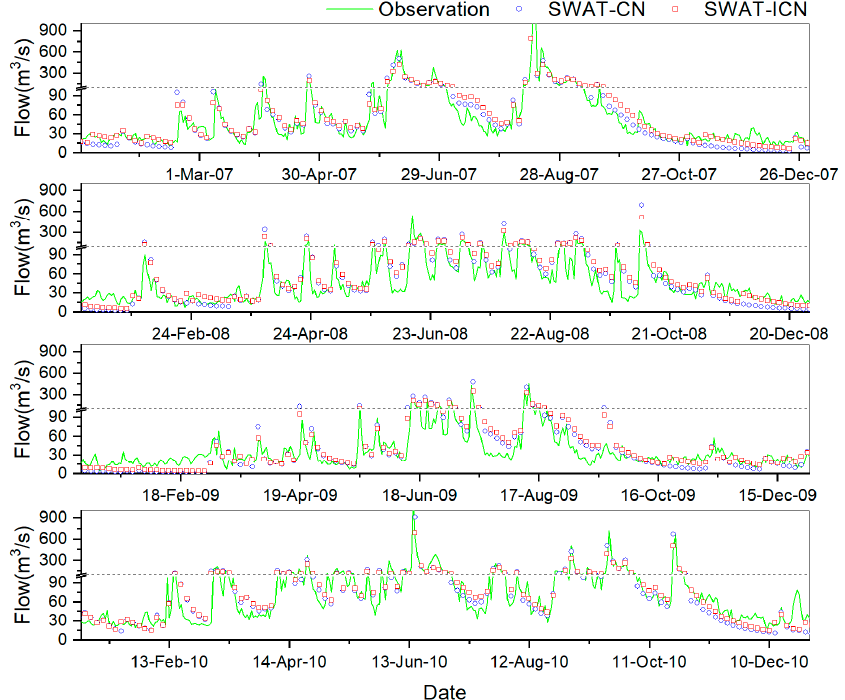
Water 2019 , 11 , x FOR PEER REVIEW Figure 5. Simulated and observed hydrographs for the validation period. Figure 5. Simulated and observed hydrographs for the validation period.